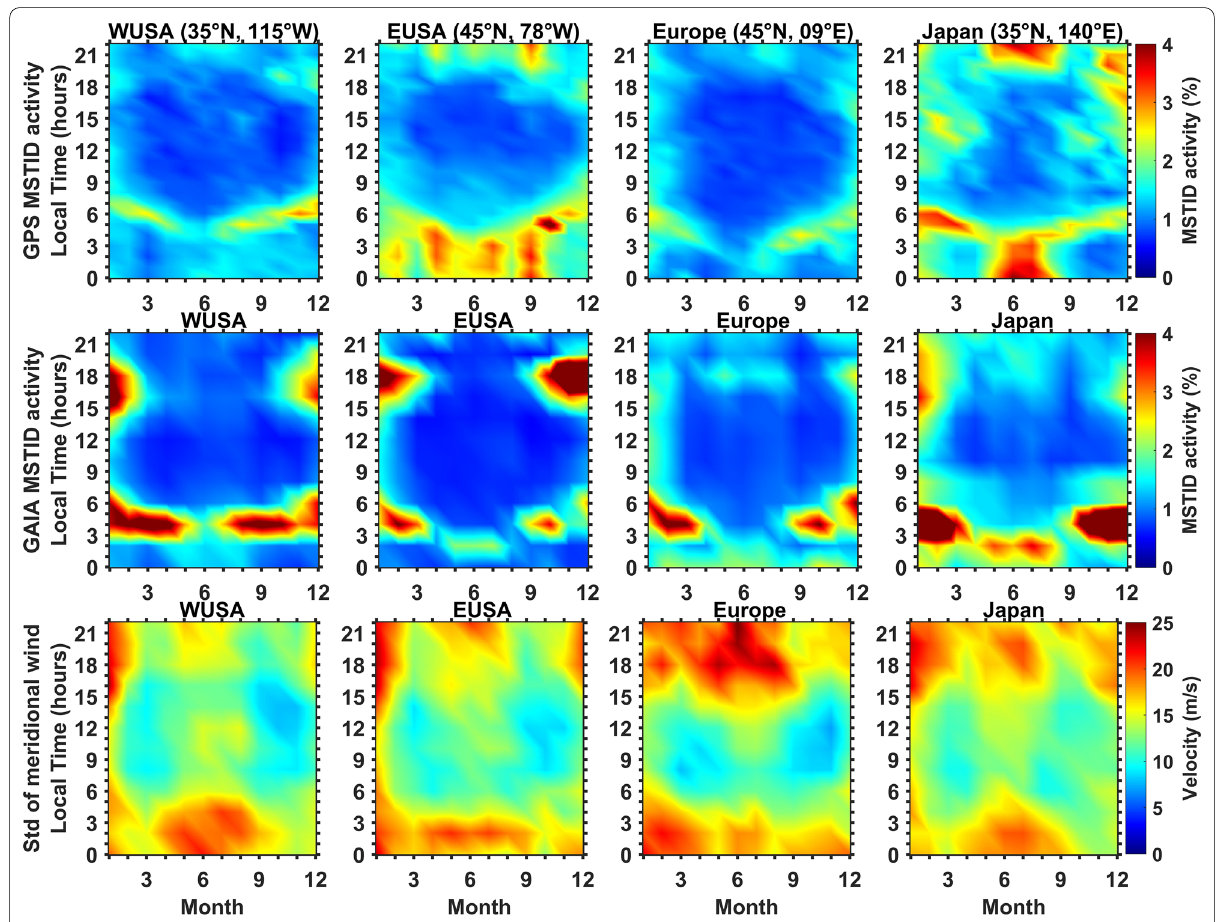
Fig. 2 Local time and seasonal variations of (top and middle) MSITD activities obtained from GPS observation and GAIA model simulation, and (bottom) standard deviation of meridional wind variation at an altitude of 300 km in GAIA model at four different locations in the northern hemisphere, viz. Western USA, Eastern USA, Europe and